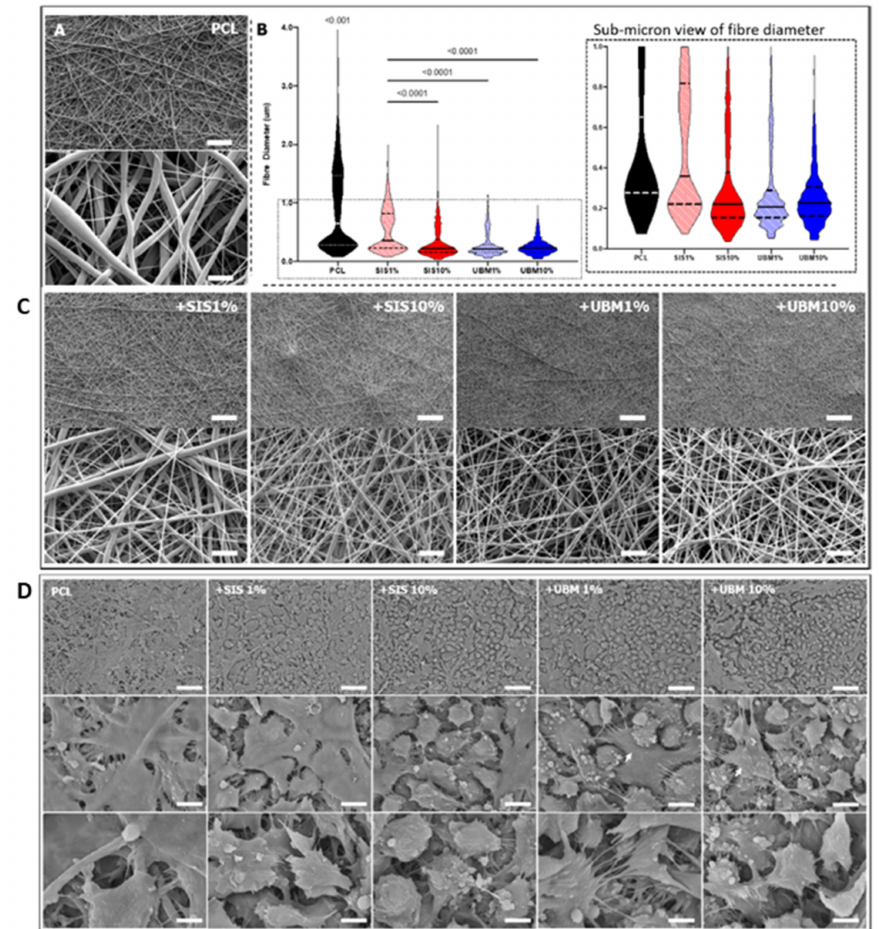
Figure 7. Scanning electron microscopy (SEM) images of electrospun PCL nanofibers without any decellularised ECM (dECM) added to the formulation ( A ) or with 1% or 10% dECM from either small intestinal submucosa (SIS) or urinary bladder matrix (UBM) (C) . The fibre diameter decreased significantly with the addition of any dECM, as shown in the violin plot ( B ). Human conjunctival epithelial cells were cultured on the nanofibrous scaffolds. The SEM images showed that the fibres that contained dECM induced the stratification of the cells. ( D ) Reprinted from Bosworth et al. in accordance with CC BY 4.0